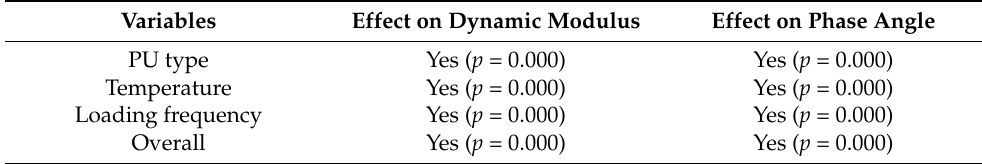
Table 6. Statistically significant effect of the PU type on the dynamic modulus and phase angle.